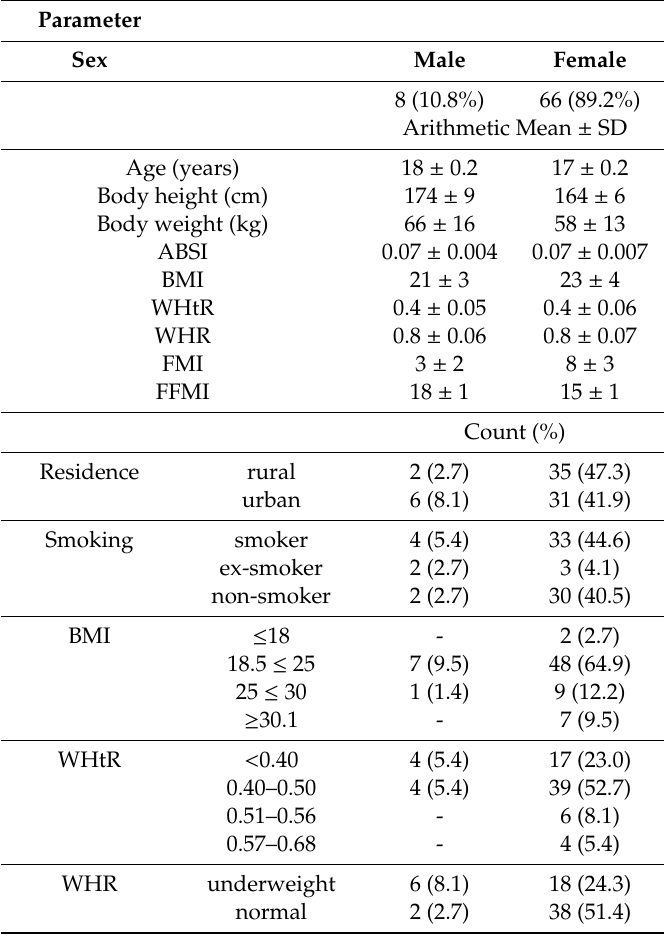
Table 2. Baseline characteristics of study